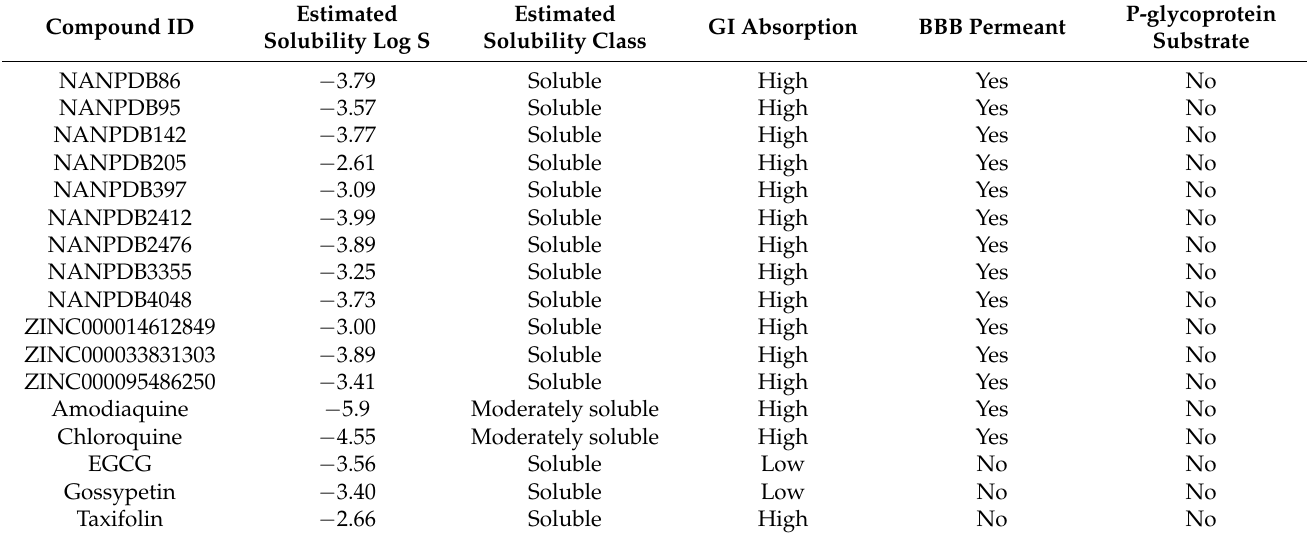
Table 3. Pharmacokinetic profile of the top 12 compounds and 5 known EBOV VP35 inhibitors comprising of Estimated Solubility (ESOL). Blood Brain Barrier (BBB), Gastrointestinal (GI) and P-glycoprotein (Pgp). Compound